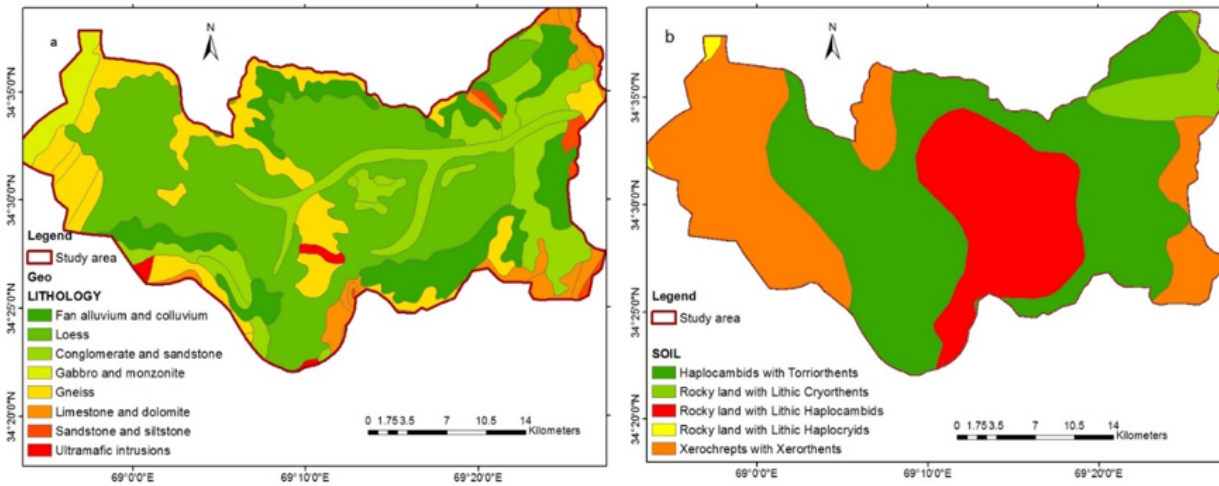
Figure 5. Maps of the conventional data: ( a ) lithology; ( b ) soil texture.